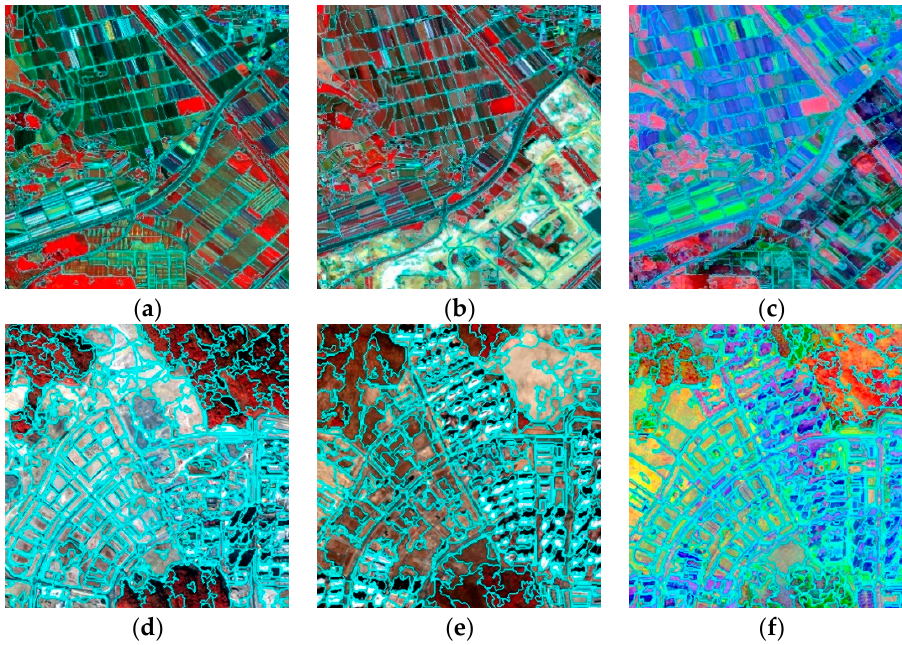
Figure 8. Colored infrared images with the boundary of segmentation for 𝐼 (cid:3047)(cid:2869) at ( a ) Site 1 and ( d ) Site 2 and 𝐼 (cid:3047)(cid:2870) at ( b ) Site 1 and ( e ) Site 2. Colored composites of PCs with the segmentation results for ( c ) Site 1 and ( f ) Site 2.